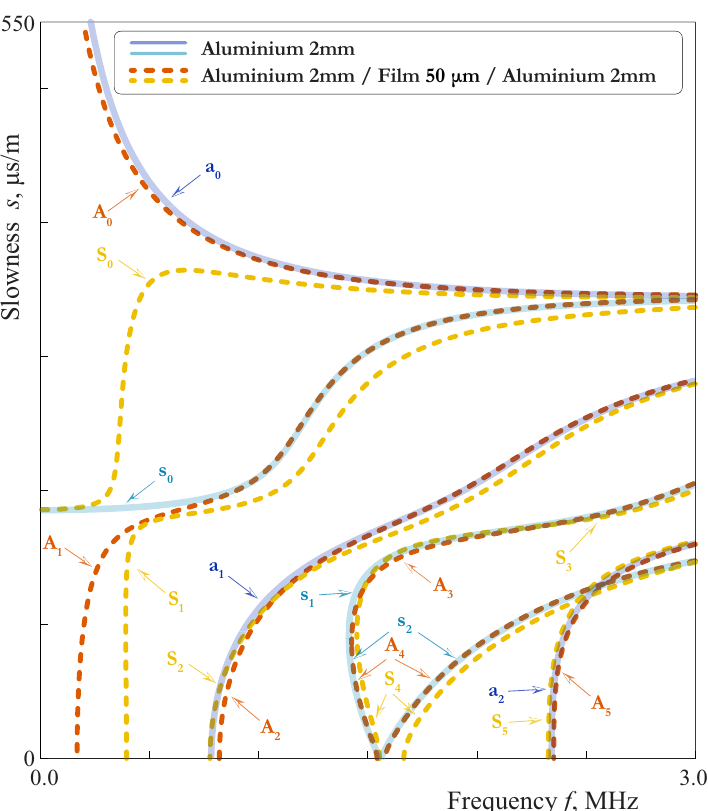
Figure 2. Slownesses of LWs propagating in 4.05 mm thickness plate (2 mm aluminium/50 µ m film/2 mm aluminium) and 2 mm thickness aluminium plate.